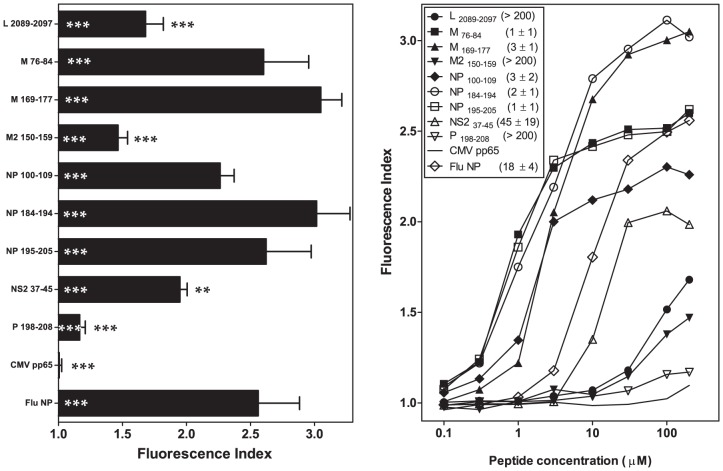
HLA-B*2706 stabilization with synthetic HRSV ligands.The stability of HLA-B*2706/peptide complexes on the cell surface of transfected RMA-S cells was measured through flow cytometry. The results shown in left and right panels are depicted as in Fig. 1A and 2B, respectively, showing the mean values obtained from three or four independent experiments.